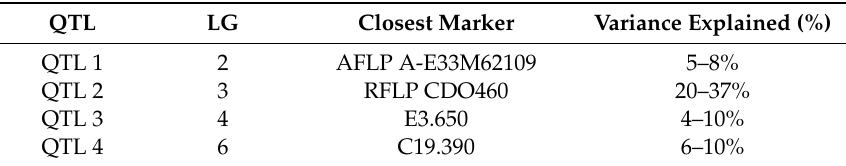
Table 5. Additional QTLs for gray leaf spot resistance